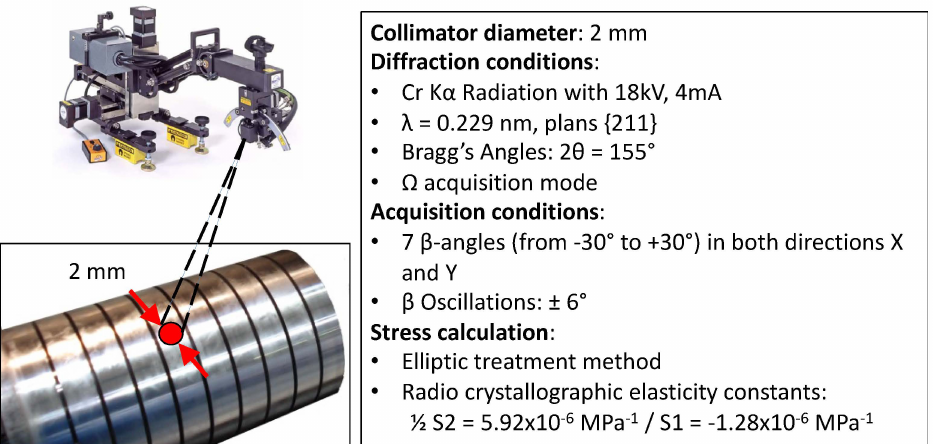
Figure 4. Measuring conditions of residual stresses by X-ray